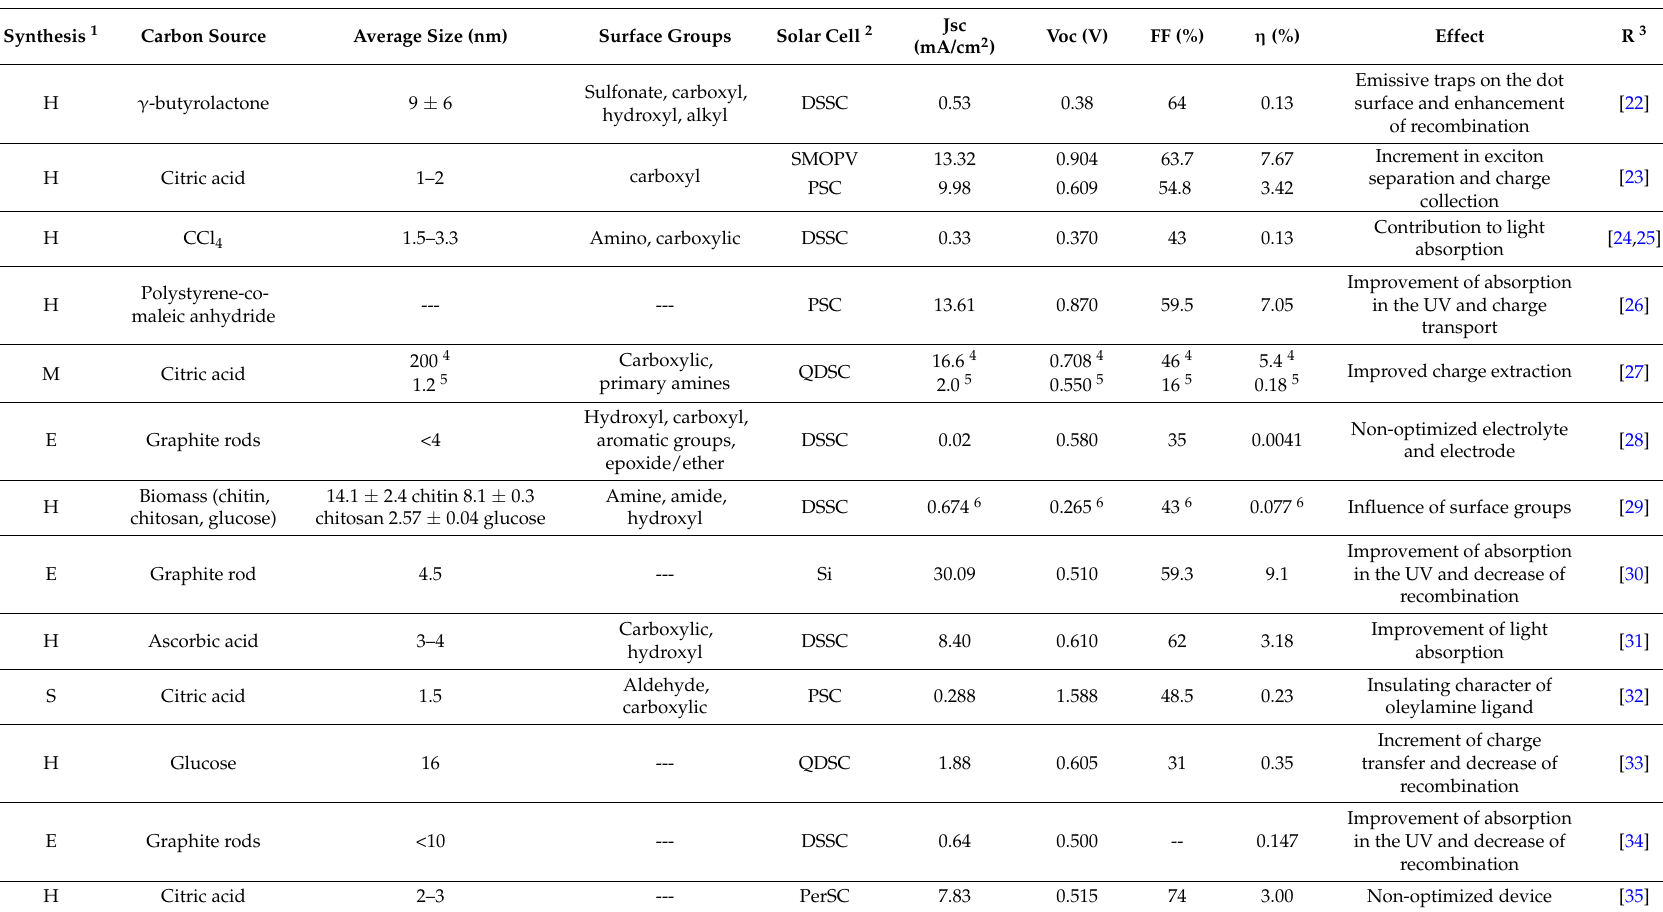
Table 1. Summary of the synthetic techniques of CDs included in this article, the resulting size and functional groups and the performance of the photovoltaic cells in which they are